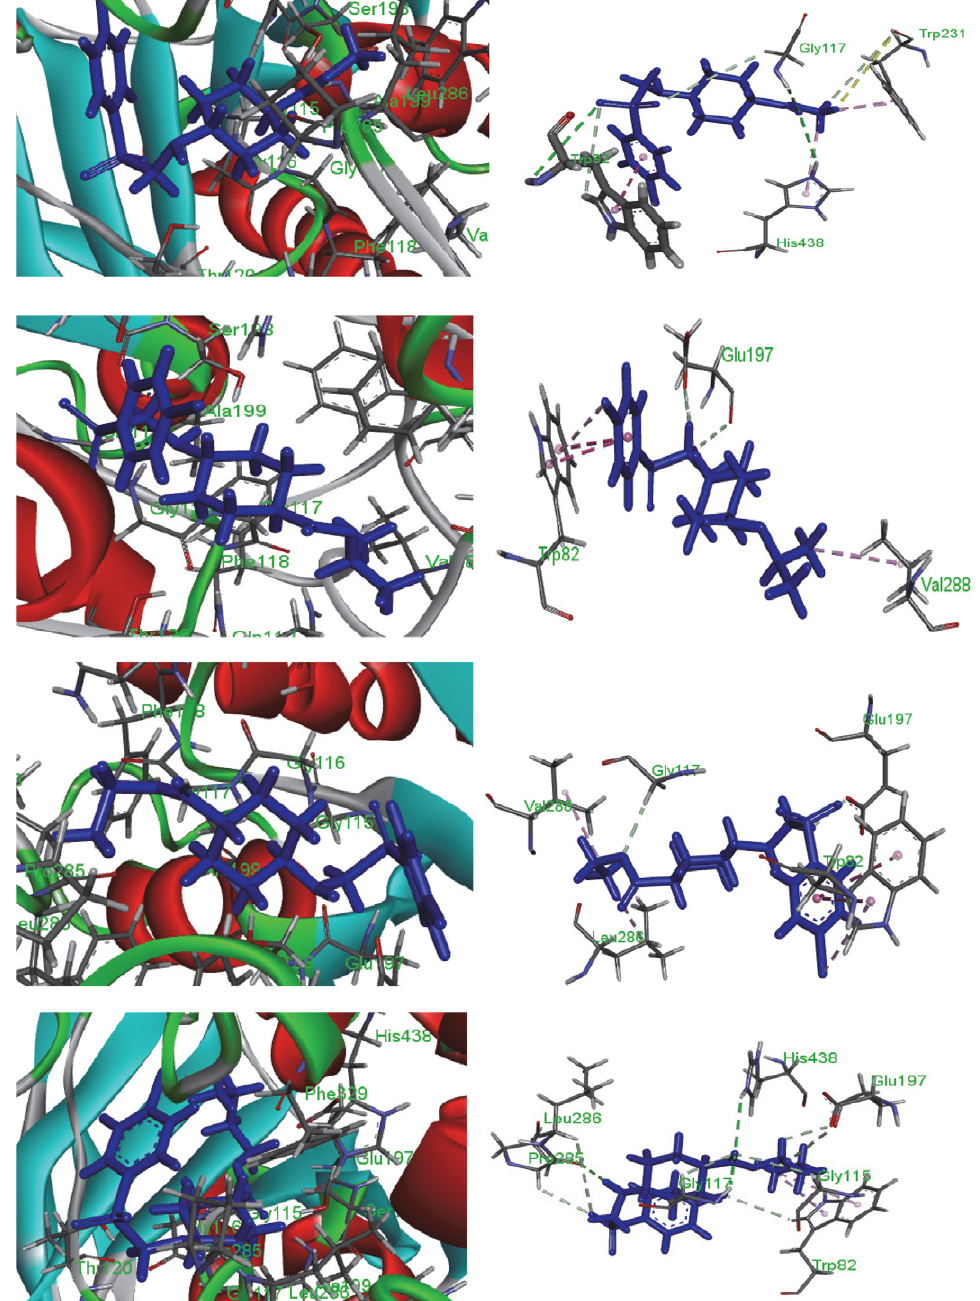
Figure 6. Best docking-poses of the synthesized compounds in the binding site of 1POI